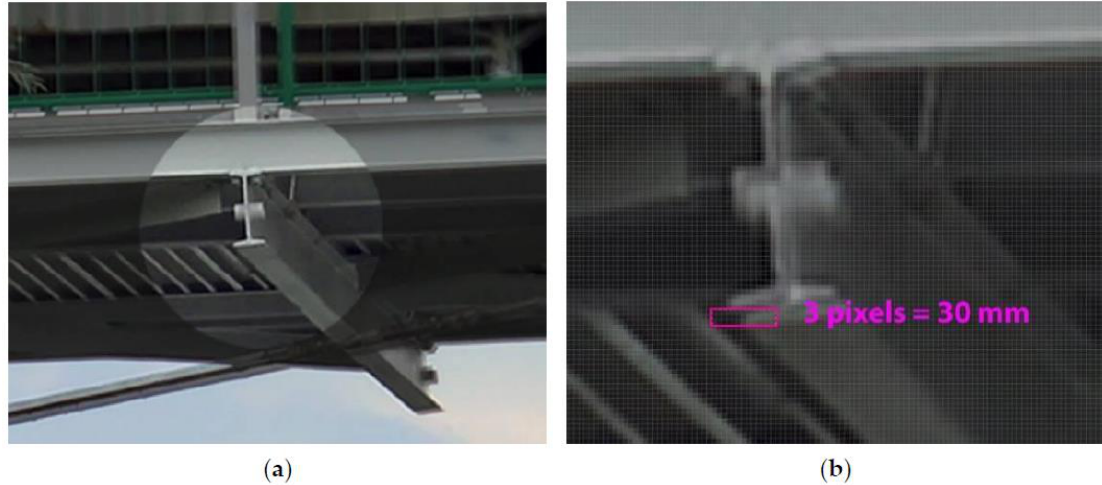
Figure 13. The analyzed detail in 3 / 4 of the bridge span: ( a ) without load, ( b ) images superimposed (without and with load) showing the scale of the bridge deflection under dynamic loads (load scenario C).